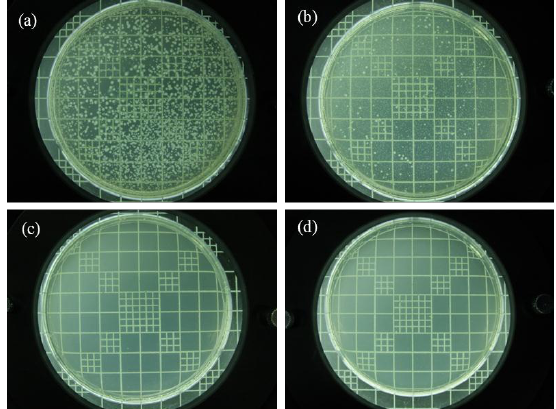
Figure 6. Antibacterial ability against Staphylococcus aureus . ( a ) blank and with zein/Ag nanoparticles containing Ag concentrations of ( b ) 0 wt %; ( c ) 2 wt %; and ( d ) 4 wt % (after one week).